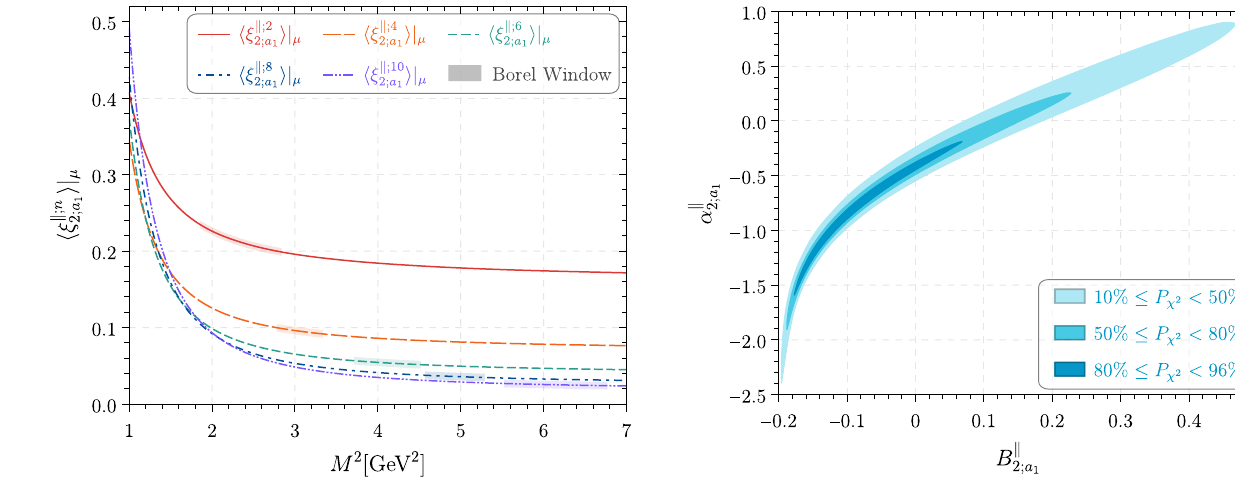
(cid:3); n (cid:4)| μ up to n = ( 2 , 4 , 6 , 8 , 10 ) order level versus 2 ; a 1